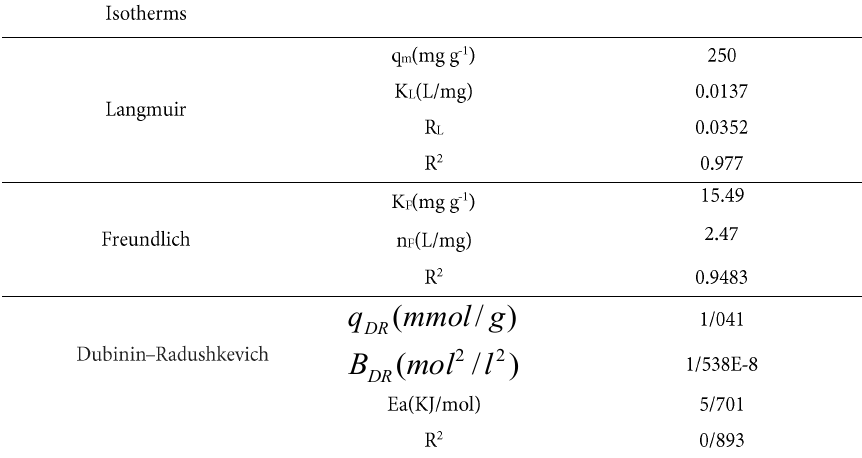
Table 2. Sorption isotherm parameters of Cs(I) (at concentrations of 50, 100, 250, 500, 1000, and 2000 mg L-1 at constant pH 7.0 and temperature 25